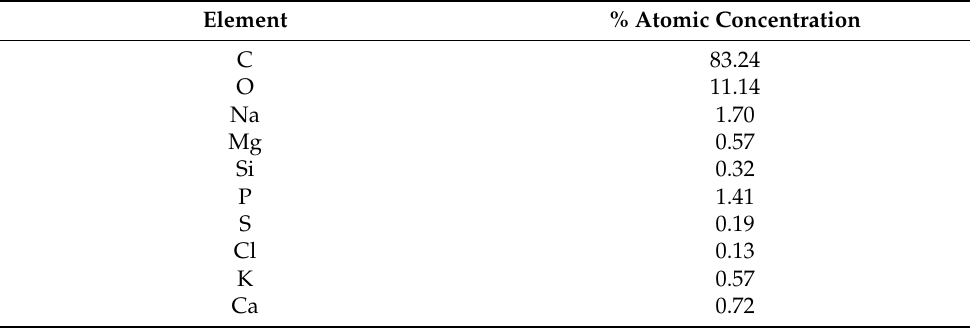
Figure 3. Representative SEM images of Na–BC ( A ), ( B ) and EDX analysis ( C ). Table 1. % Atomic concentration of elements in Na–BC determined by the EDX